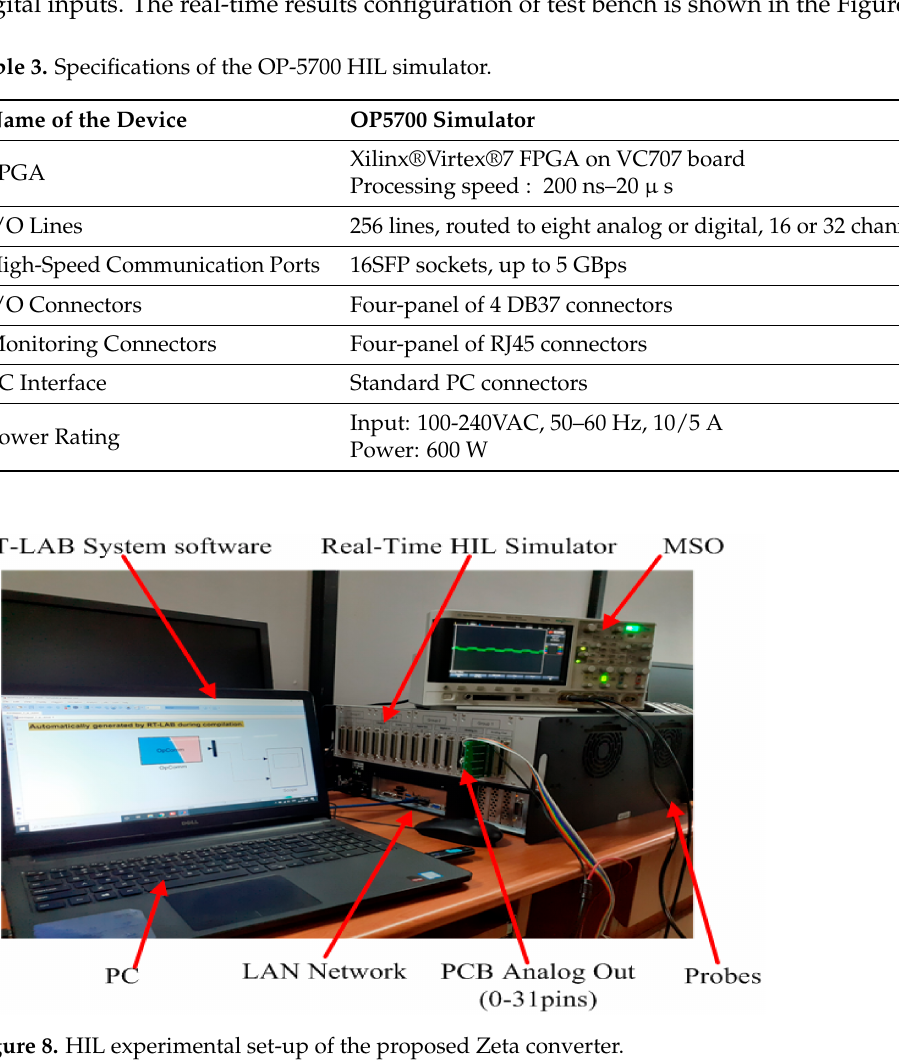
Figure 8. HIL experimental set-up of the proposed Zeta